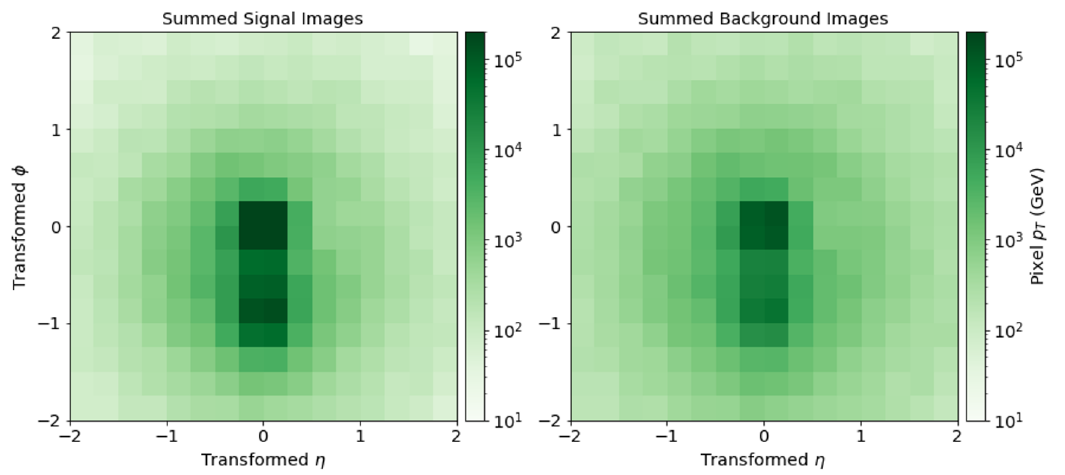
Figure 9. Aggregated Signal ( Zbb ) and Background (QCD) Jet Images after